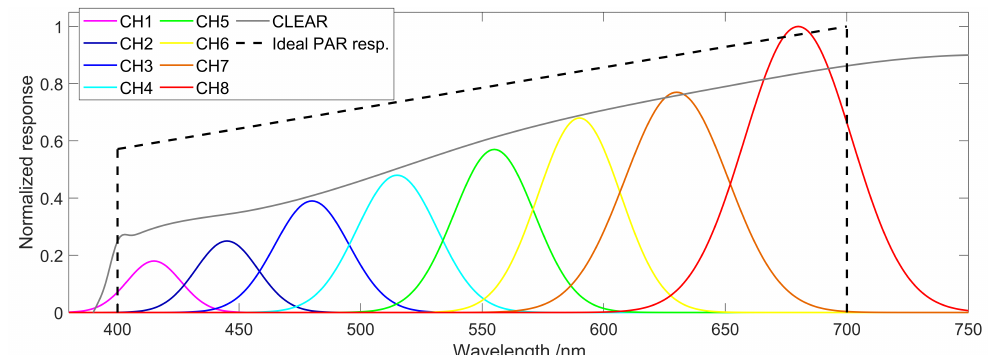
Figure 1. Spectral responsivity according to the AS7341 datasheet [23] (graph redrawn with permis- sion). The eight channels show the whole PAR spectrum. Not shown is a channel with a sensitivity in the near infrared at 910nm.